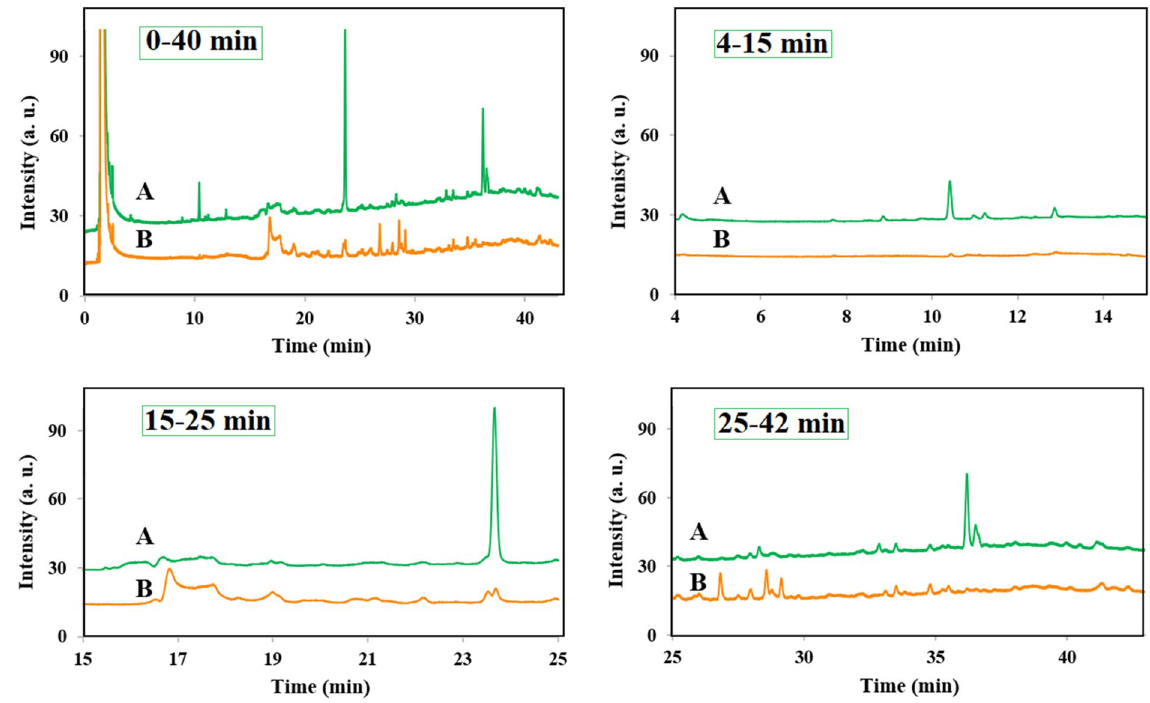
Figure 9. GC analysis spectra of real produced water sample before ( A ) and after ( B ) AOP treatment using (N, S)-MPC catalyst at four retention time regions including 0–40, 4–15, 15–25, and 25–42